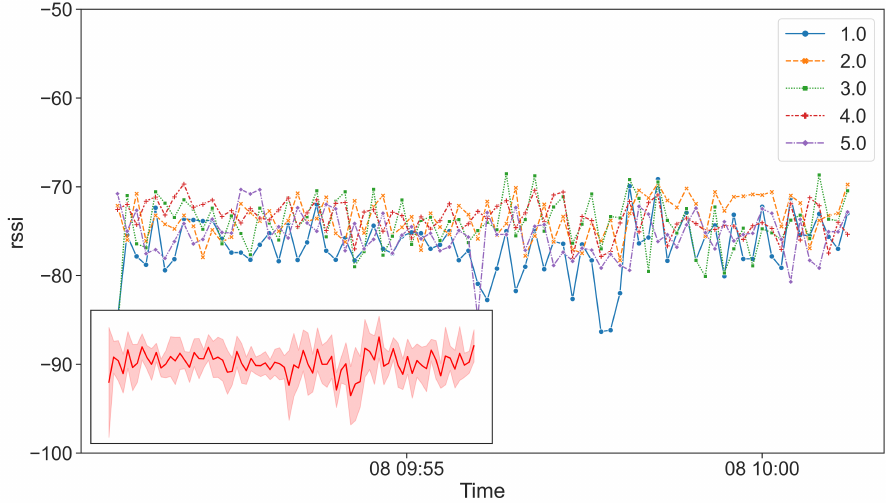
Figure 13. RSS time series of 5